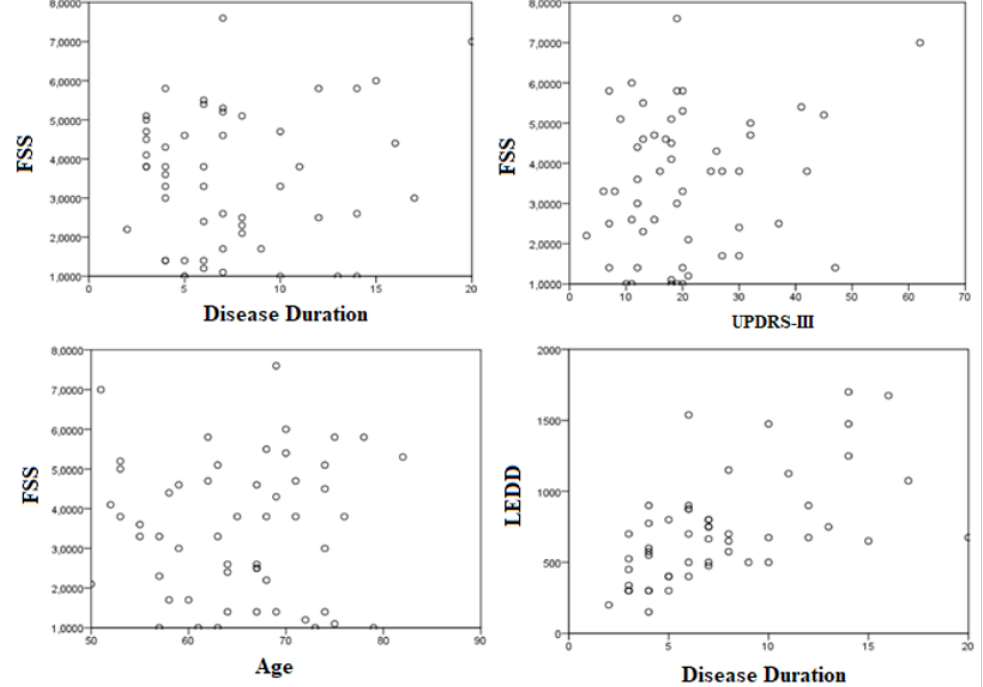
Figure 2. Negative correlation between age, disease duration, Unified Parkinson’s Disease Rating Scale part III, and